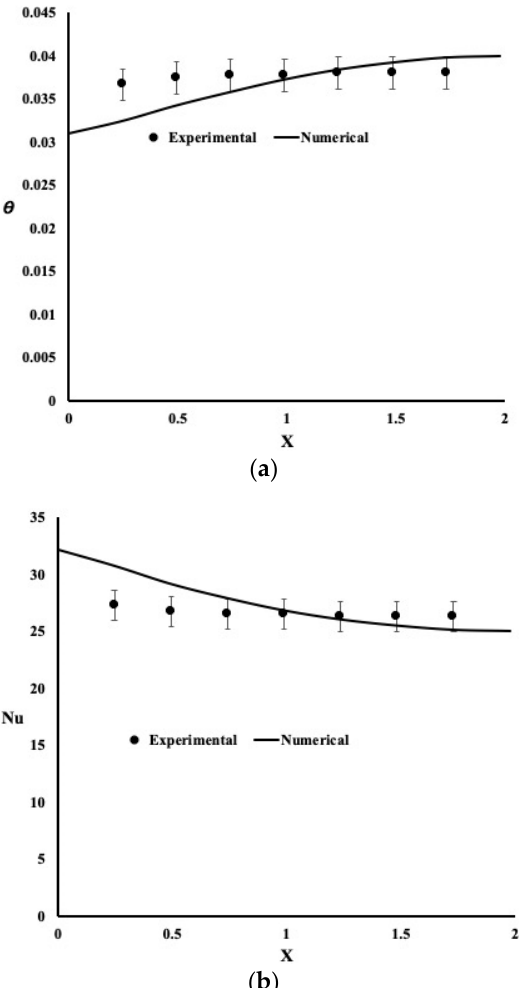
Figure 4. Comparison with experimental data for porous channels condition. ( a ) Temperature dis- tribution, ( b ) Nusselt number variation.